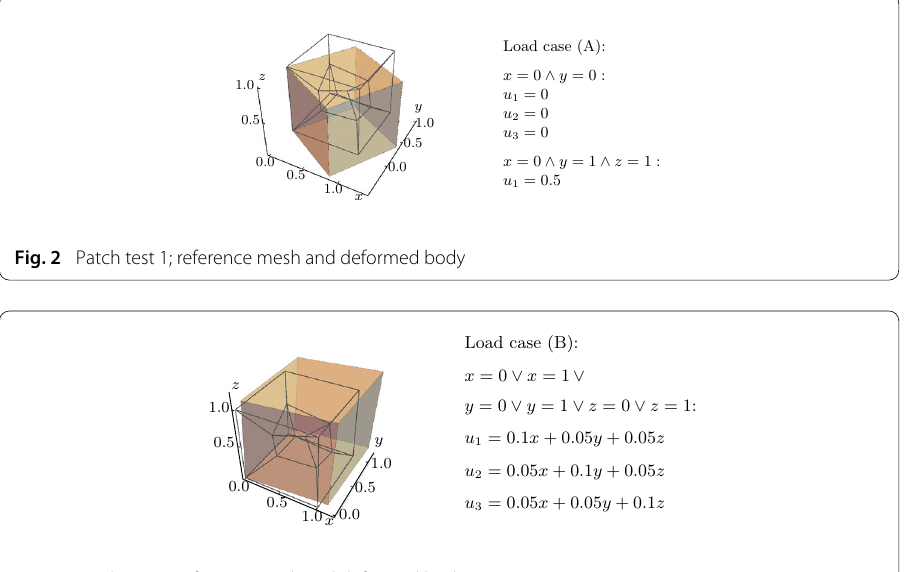
Fig. 3 Patch test 2; reference mesh and deformed